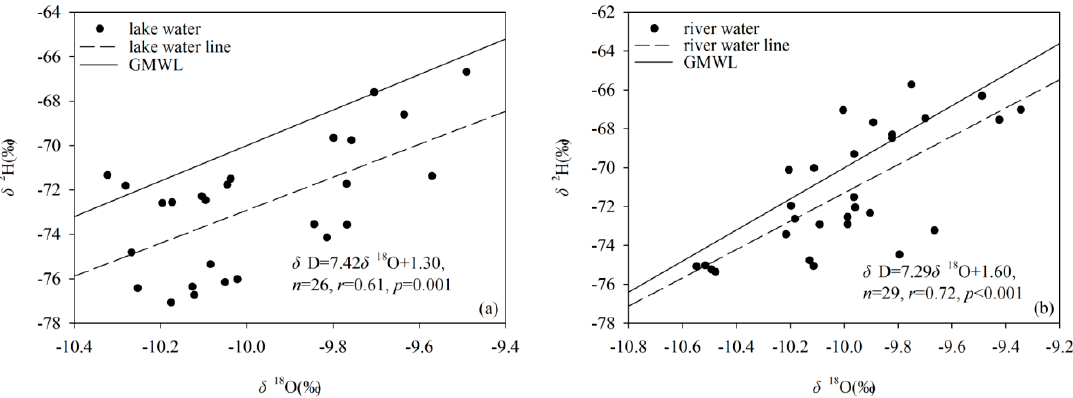
Figure 4. The relationship between δ 2 H and δ 18 O in ( a ) lake water and ( b ) river water from January 2016 to March 2017. The global meteoric water line (GMWL) is based on Craig [38].